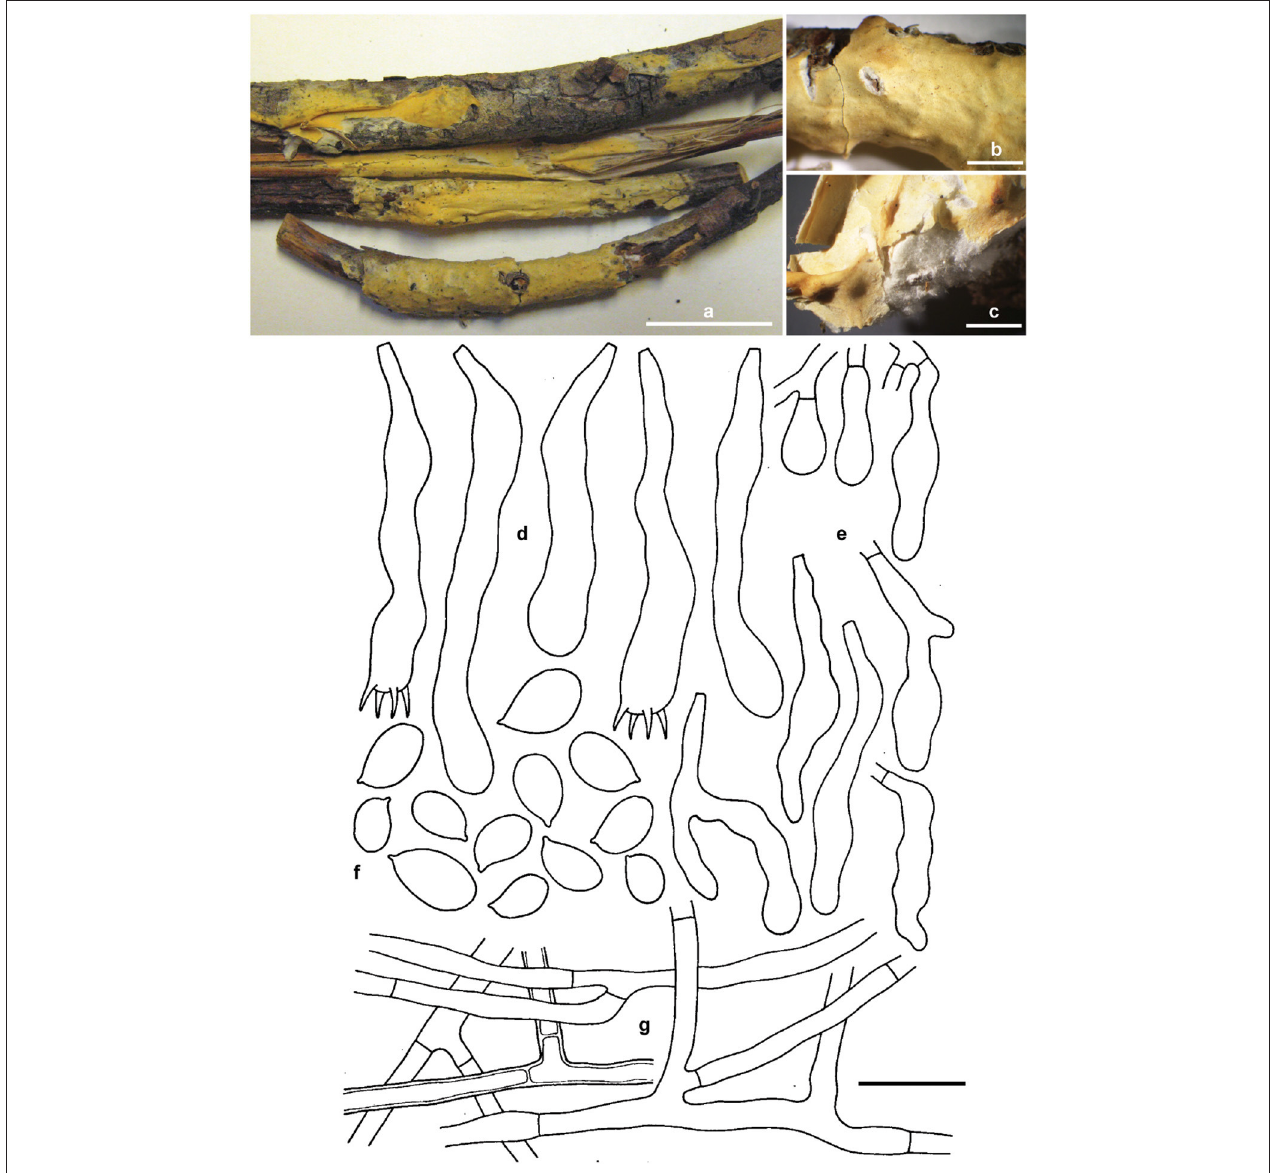
FIGURE 7 | Erythricium vernum sp. nov. (a) basidiomata, holotype; (b,c) basidiomata, RLG-7886; (d) basidia; (e) basidioles; (f) basidiospores; (g) subicular hyphae. Scale bars (a) 2cm; (b,c) 0.5cm; (d–g) 20 µ m. Photos (a) by M. Ghobad-Nejhad; (b,c) by K. Nakasone. Line drawing: reproduced with permission from Gilbertson